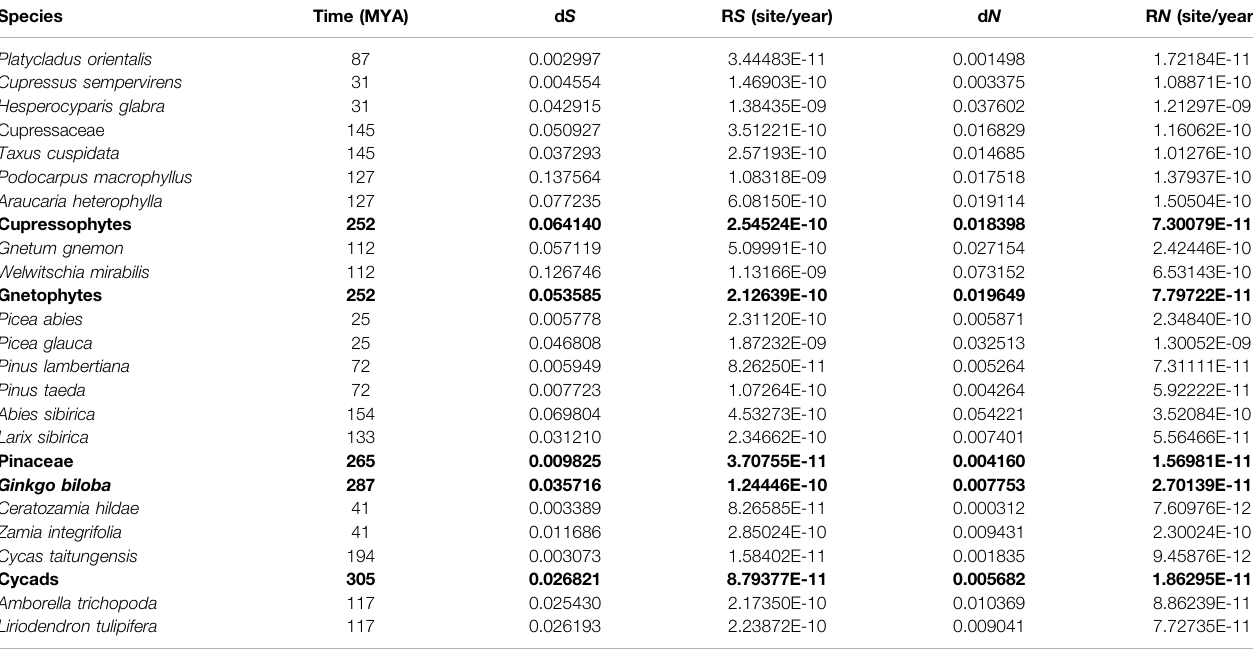
TABLE 3 | Relative (d S , d N ) and absolute (R S , R N ) synonymous and nonsynonymous substitution rates. MYA, million years ago. Species Time (MYA) d